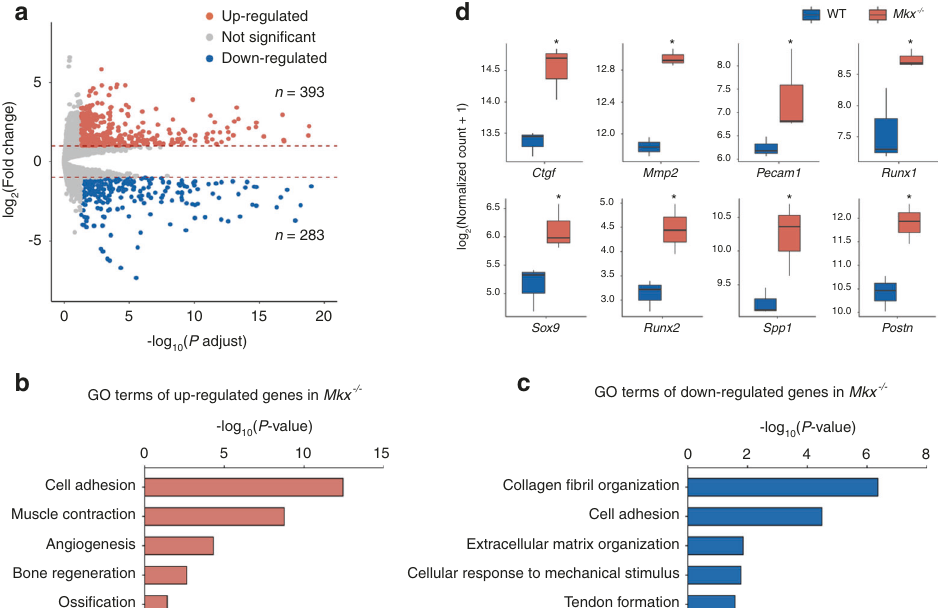
Fig. 2 Transcriptomic analysis of WT and Mkx − / − tendons. a Volcano plot of differentially expressed genes between WT and Mkx − / − tendons. b Representative enriched GO terms corresponding to upregulated genes in Mkx − / − tendons. c Representative enriched GO terms corresponding to downregulated genes in Mkx − / − tendons. d Boxplots of the expression levels of genes related to angiogenesis ( Ctgf , Mmp2 , Pecam1 and Runx1 ) and osteochondrogenesis ( Sox9 , Runx2 , Spp1 and Postn ) in WT and Mkx − / − tendons. *: p <